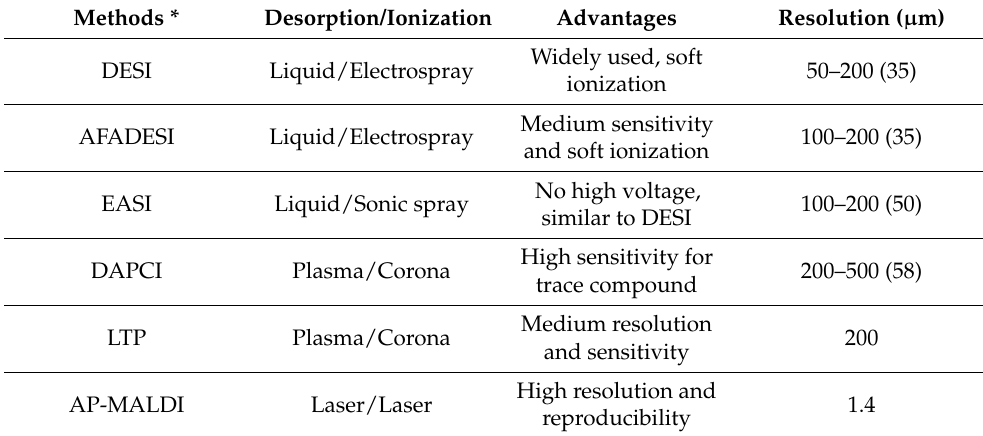
Table 1. Summary of one-step desorption/ionization for